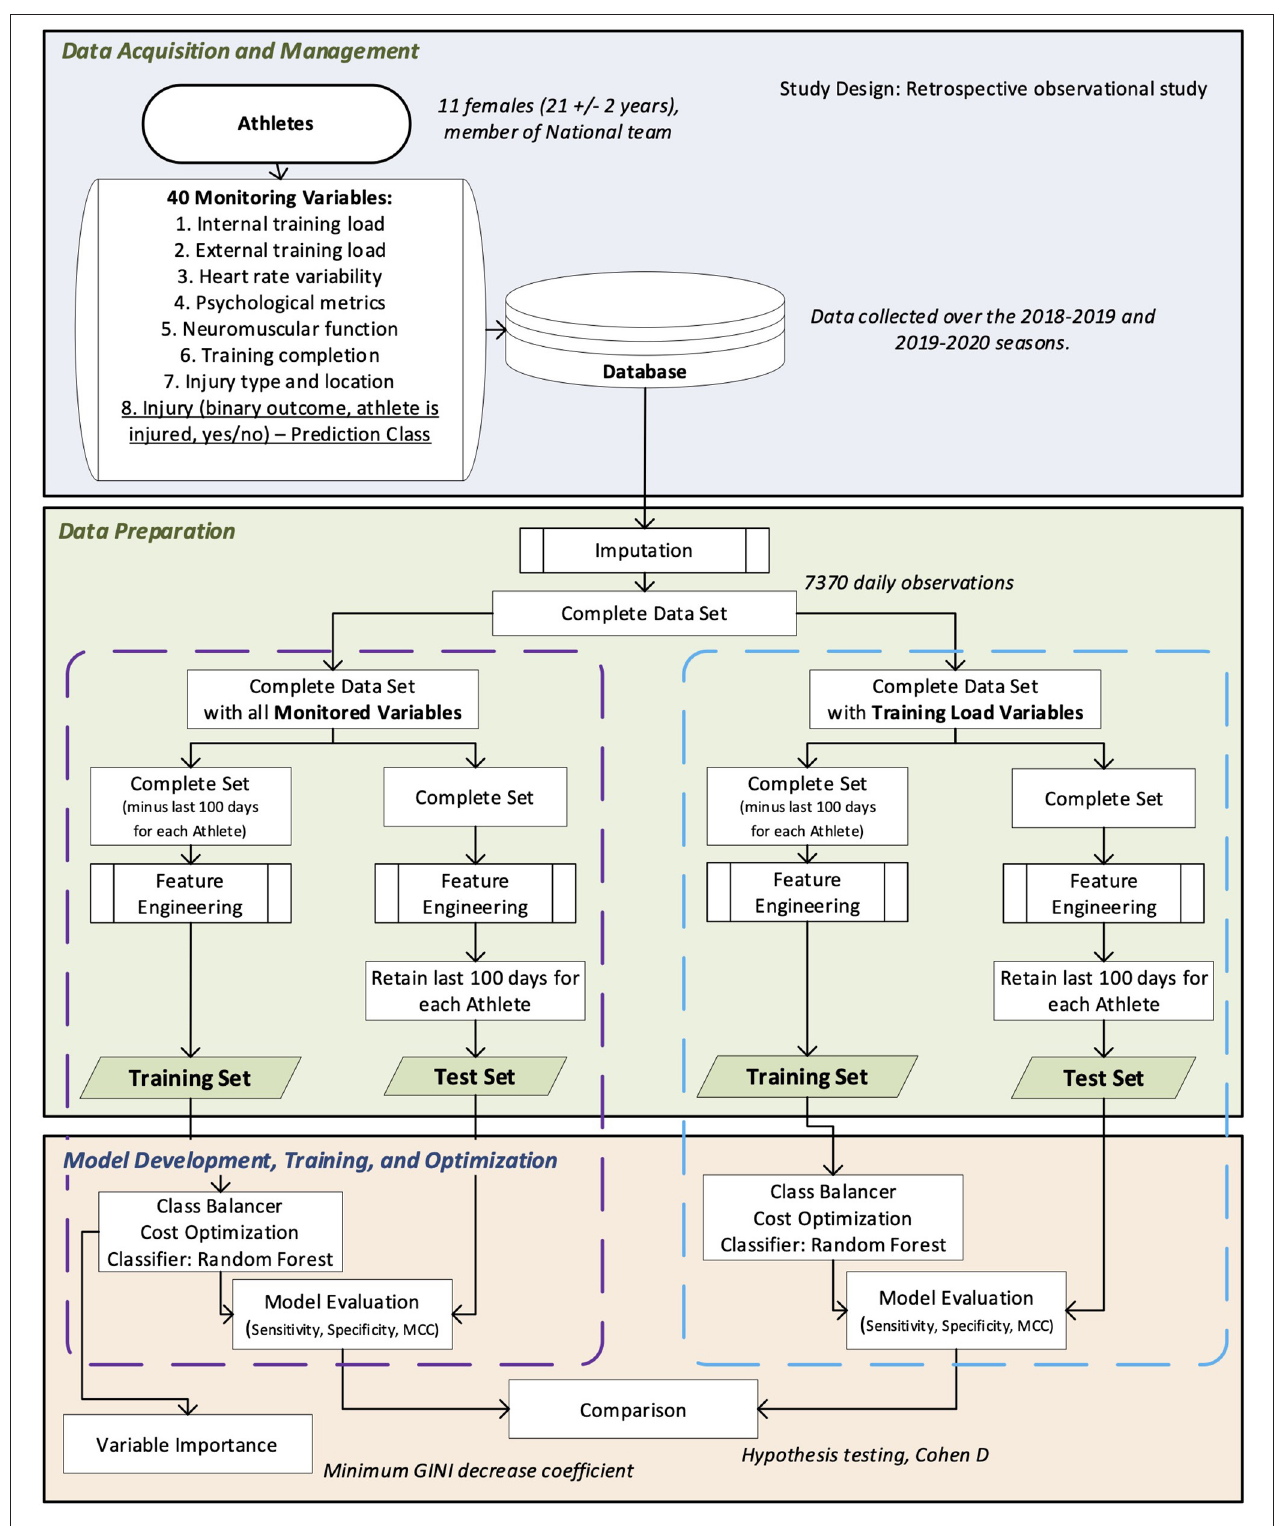
FIGURE 1 | Overview of the data mining framework to develop and evaluate random forest forecasting models.